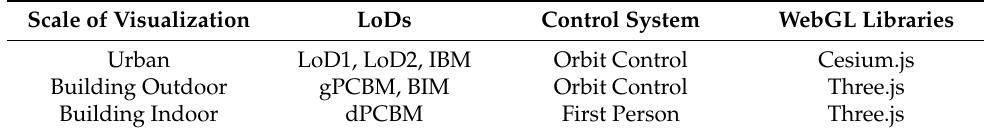
Table 2. The dataset used for each scale of navigation.